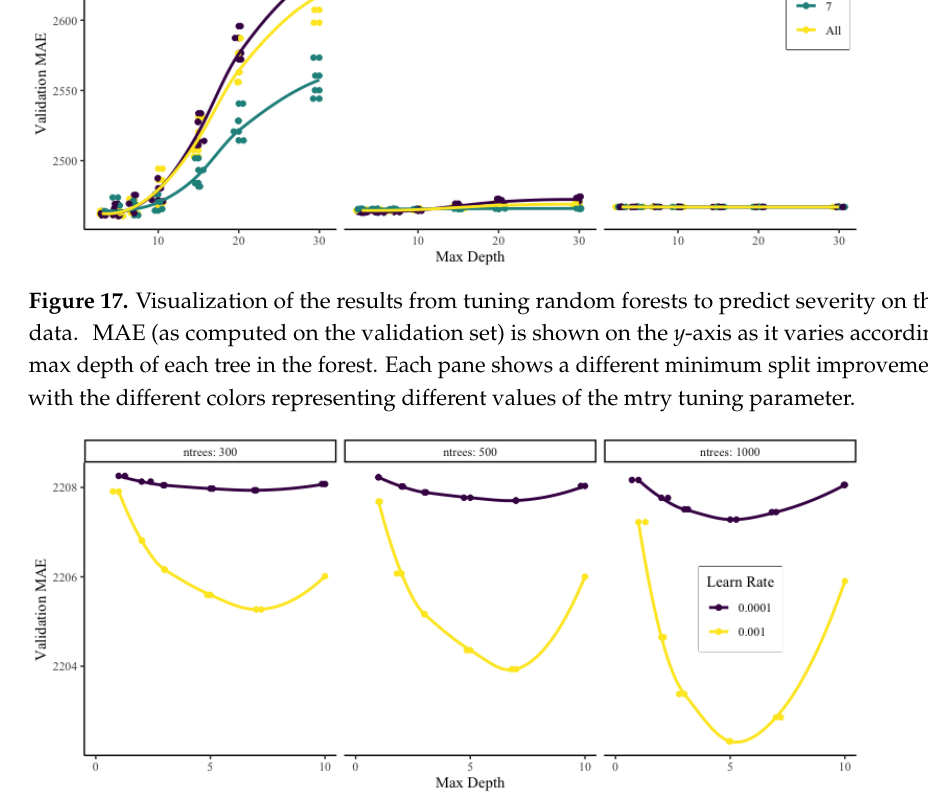
Figure 18. Visualization of the results from tuning gradient boosted forests to predict severity on the COLL data (note that only models with the distribution tuning parameter set to “Laplace” are shown since their MAE was much less than the other models). Validation MAE is shown on the y -axis as it changes according to the maximum depth of each tree in the gradient boosted forest. Each pane shows a different number of trees in the forest while each colored line represents a different learning